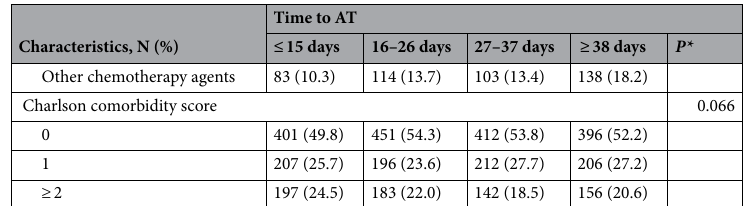
Table 1. Patient characteristics in SEER-Medicare analytic cohort by time to AT (N = 3159). AT adjuvant therapy, DWS divorced/widowed/separated, RT radiation therapy, CRT chemoradiation, TMZ temozolomide, NA not available, was presented once the number of patients in a specific cell was 11 or less based on privacy policy of SEER-Medicare. *Pearson’s χ 2 test or Mann–Whitney U test were conducted to compare the proportions of baseline characteristics across time to AT.